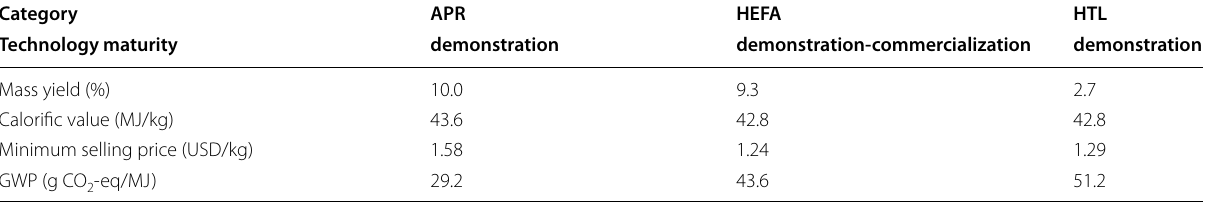
Table 8 Comparison of three bio-jet fuel technical paths